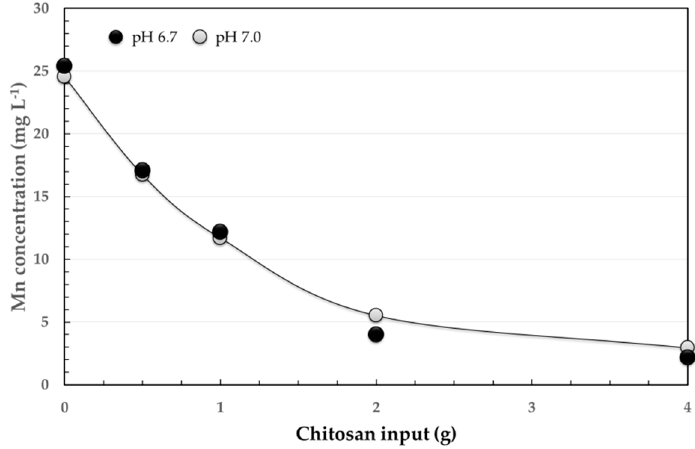
Figure 6. Change in Mn concentration and the amount of Mn removal at pH 6.7 and 7 as a function of input amount of chitosan.